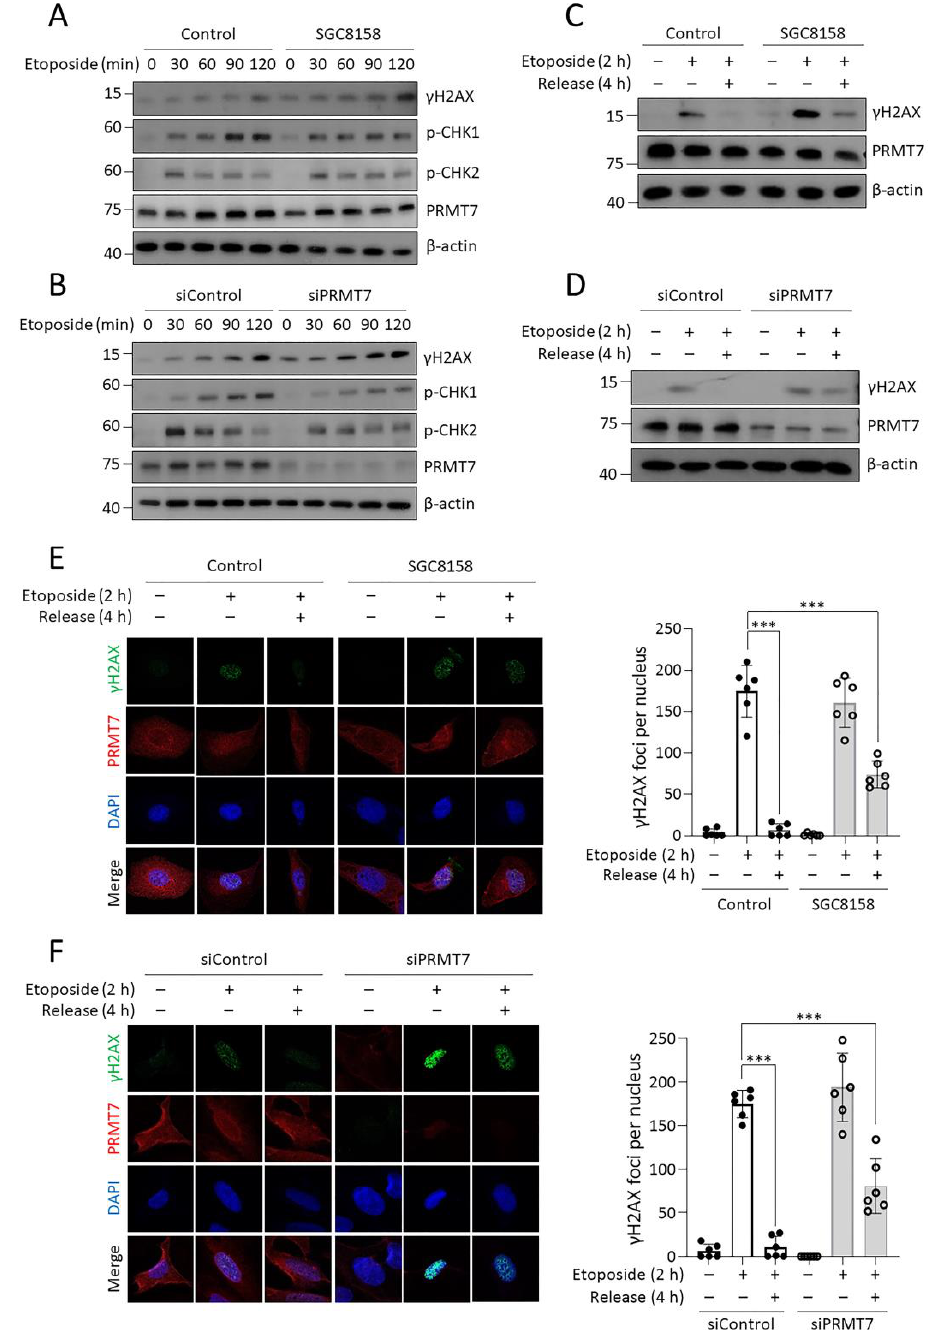
Figure 3. PRMT7 regulates DNA damage response. ( A , B ) Levels of DNA damage-associated proteins using western blotting. U2OS cells were treated with 10 μM SGC8158 ( A ) or transfected with PRMT7 siRNA ( B ) for 2 days, followed by treatment with 10 μM etoposide for indicated times. Cell lysates were subjected to immunoblotting analysis with the indicated antibodies. ( C – F ) Analysis of γH2AX levels during DNA repair process. After suppressing PRMT7 in U2OS cells by treating with 10 μM SGC8158 ( C , E ) or the siRNA ( D , F ) for 2 days, the cells were treated with 10 μM etoposide for 2 h, and then further incubated with fresh medium without etoposide for an additional 4 h. γH2AX levels were measured using western blotting ( C , D ) or immunostaining (γH2AX; green, PRMT7; red, DAPI; blue) ( E , F ). The fluorescence intensity of γH2AX was quantified by image analysis software (630 × magnification). Data are presented as means ± SD of six independent experiments. *** p < 0.001. DAPI: 4 (cid:48) ,6-diamidino-2-phenylindole; SD: standard